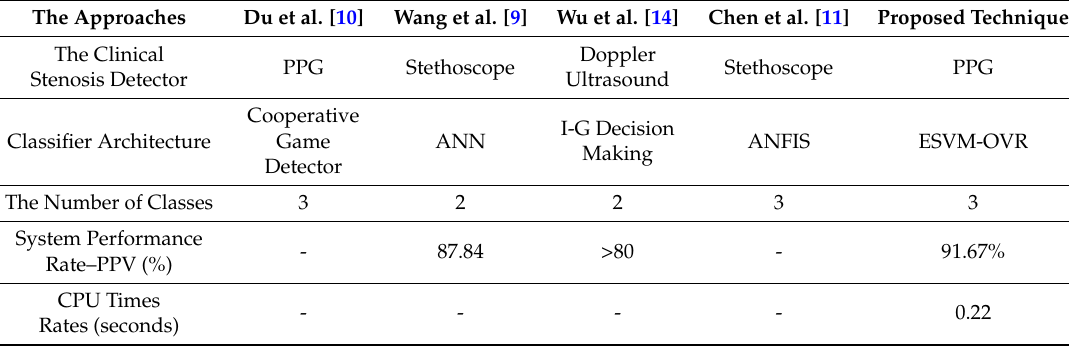
Table 7. Comparing the experimental result with other similar